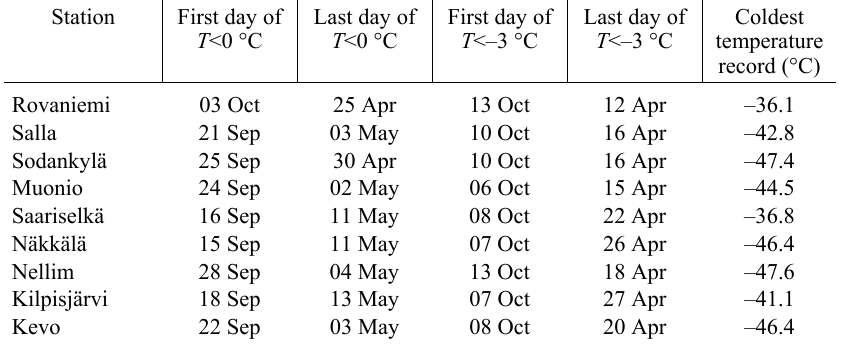
Table 3. Statistics of the air temperature averaged over 30 years (1982–2011) in Finnish